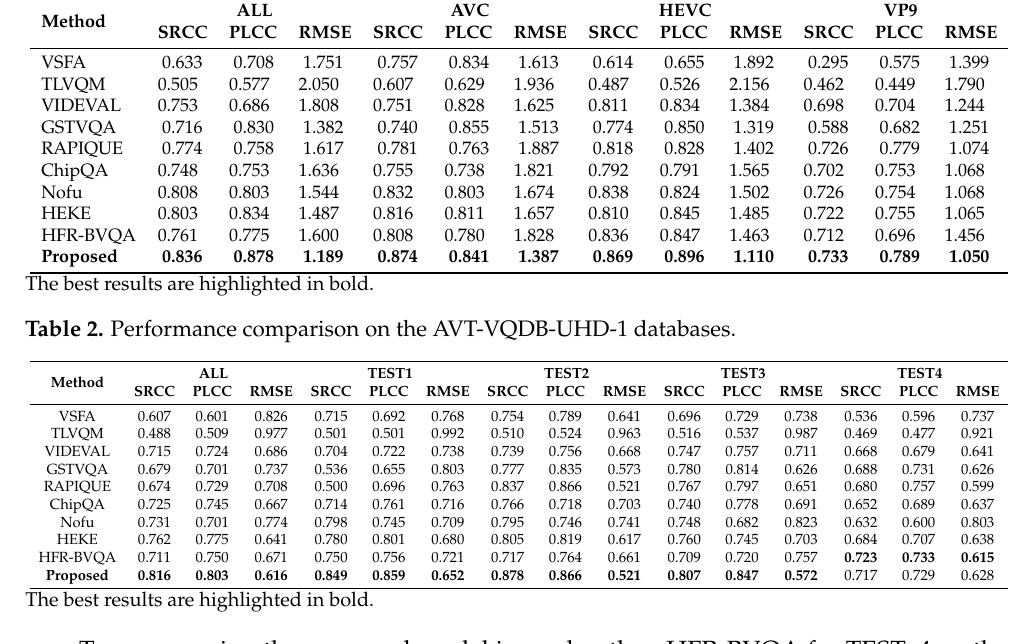
Table 1. Performance comparison on the MCML databases. ALL